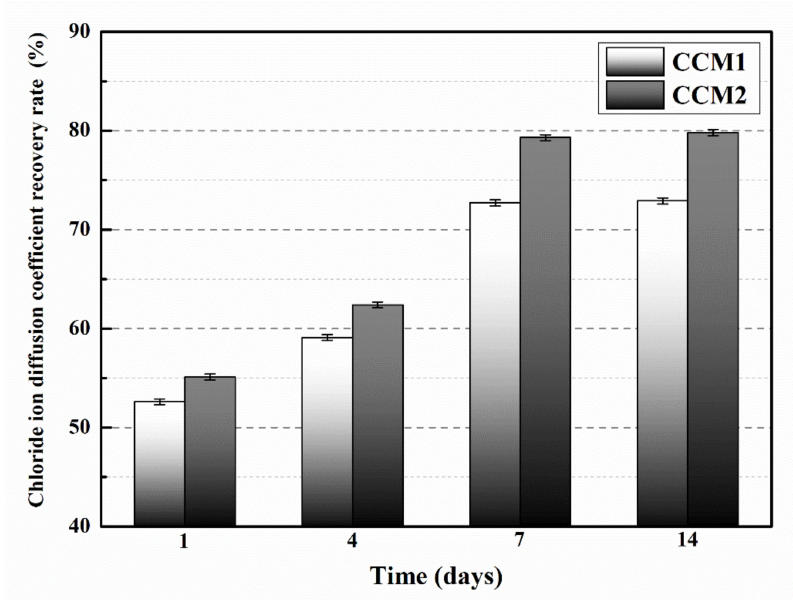
Figure 12. Chloride ion diffusion coefficient recovery rates of